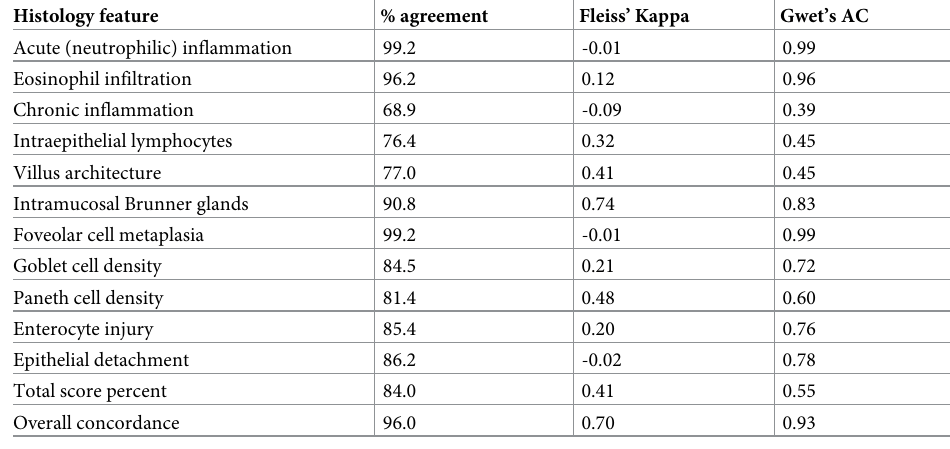
Table 4. Concordance measures of EED duodenal histology